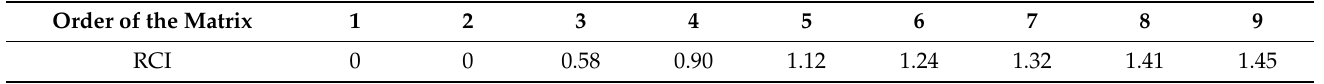
Table 2. Saaty’s consistency indices of randomly generated reciprocal